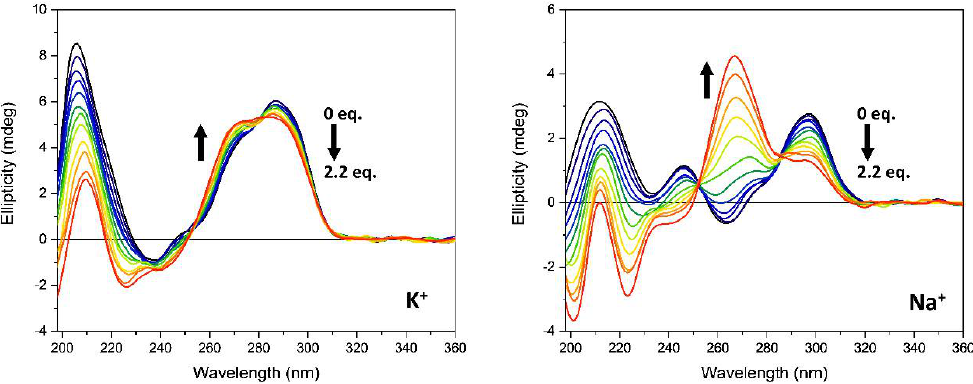
Figure 4. CD spectra of Htelo1 G-quadruplex (13.5 µ M) in the absence (black line) and in presence of increasing amounts of Rhau25 peptide in 10 mM Tris-HCl buffer, pH 7.4, 70 mM potassium ( left ) or sodium ( right ) ions. The arrows represent the direction of the signal change as the peptide concentration is increased.